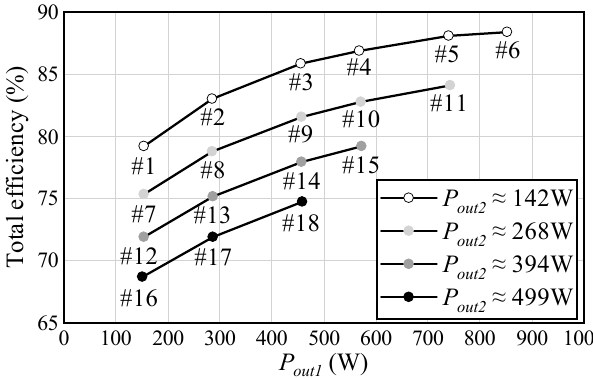
Figure 20. Results of efficiency measurements.